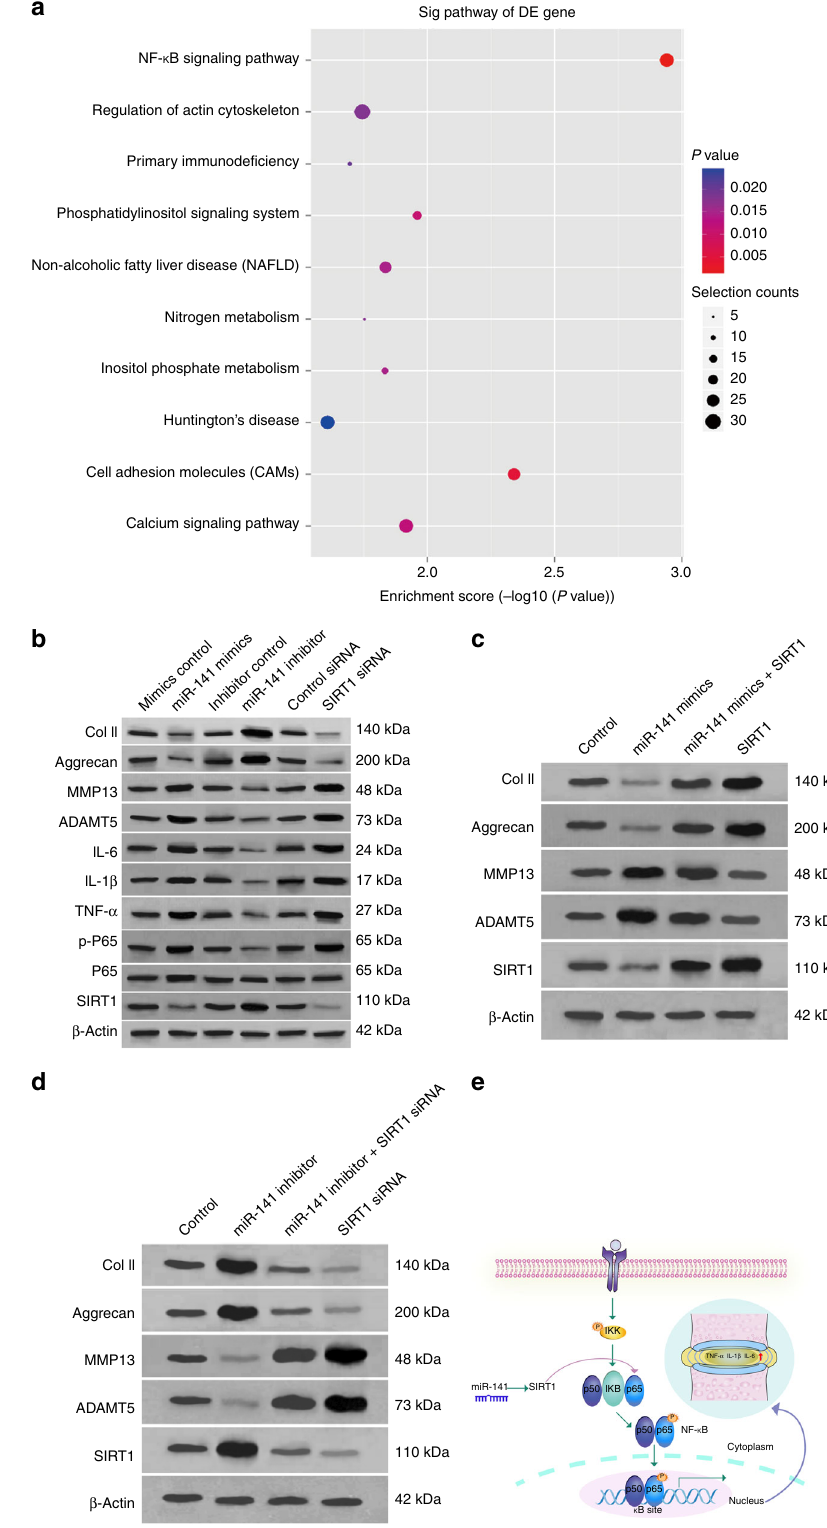
Patients with isthmic or degenerative spondylolisthesis, lumbar stenosis, ankylosing spondylitis, or diffuse idiopathic skeletal hyperostosis were excluded. The age- and sex-matched control samples were taken from 163 patients with fresh traumatic lumbar fracture who underwent anterior decompressive surgery due to neurolo- gical de fi cits. Routine magnetic resonance imaging scans of the lumbar spine